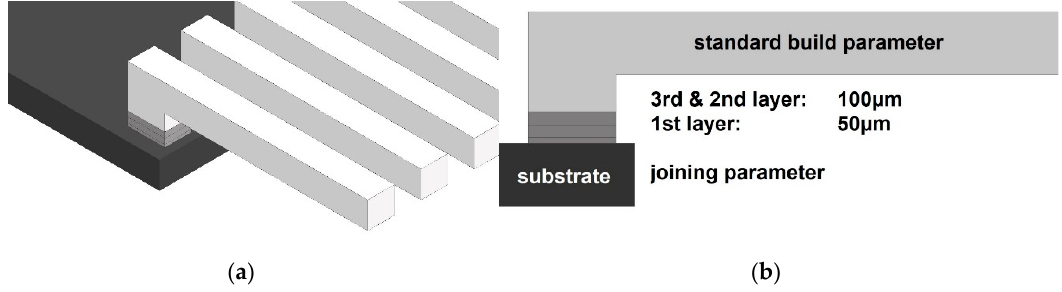
Figure 3. Schematic view. (( a ) Perspective view, ( b ) side view)) on the three binding layers (dark